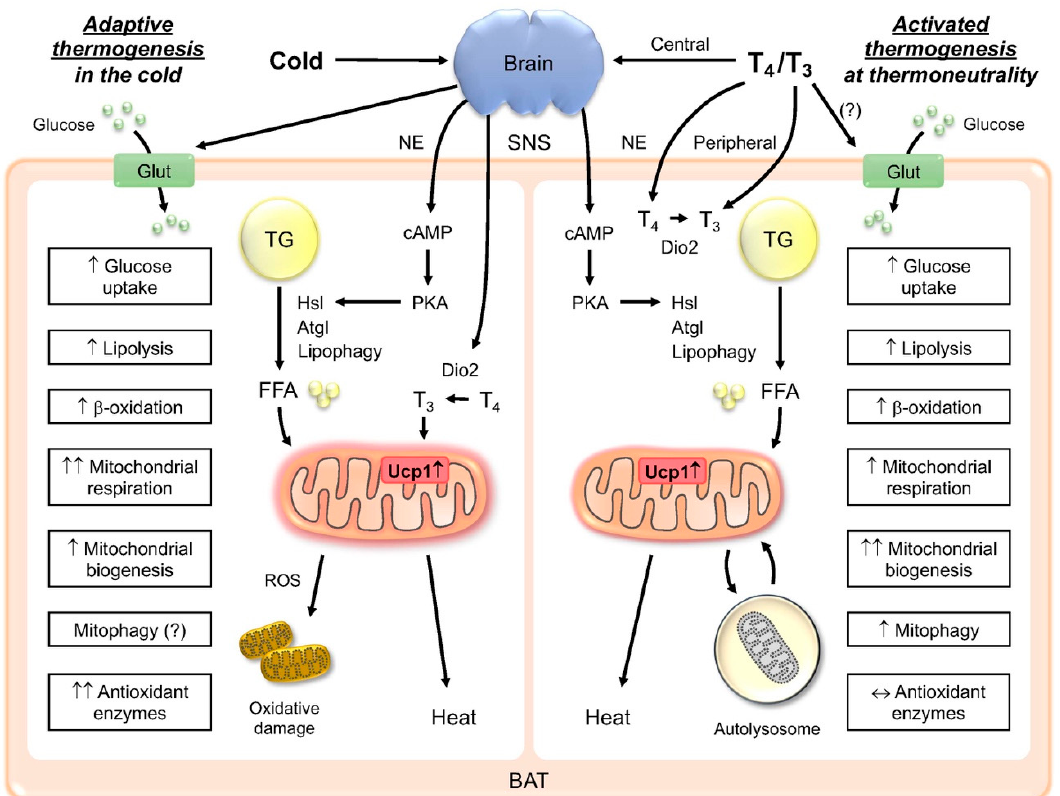
to regulate the BAT, and we also showed that local T 3 has e ff ects on BAT activation, so it appears that both central and peripheral stimulation are involved in the activated thermogenesis. Fourth, there is an increase in intracellular T 3 due to the induction of Dio2 for both types of thermogenesis; however, in the adaptive thermogenesis, the induction of serum T 3 concentration can be variable, and may depend upon the temperature and length of cold exposure. On the other hand, in the activated thermogenesis, there is a significant increase in the serum TH concentration, which also has e ff ects on other tissues besides the BAT. In this review, we would like to describe in further detail the key similarities and di ff erences between the TH-induced activated thermogenesis and the conventional cold-induced adaptive thermogenesis.